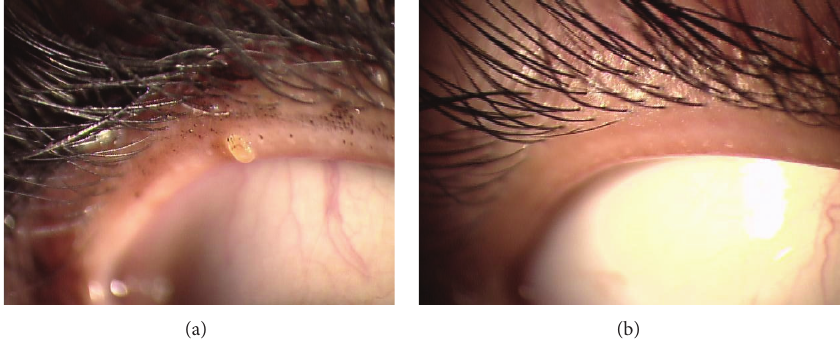
Figure 6: Plugging in the upper eyelid, with improvement after 4 weeks of intervention. (a) Week 0, with mascara and glue adhering to the eyelashes. (b) Week 4, after using artificial tears and Eye Shampoo.